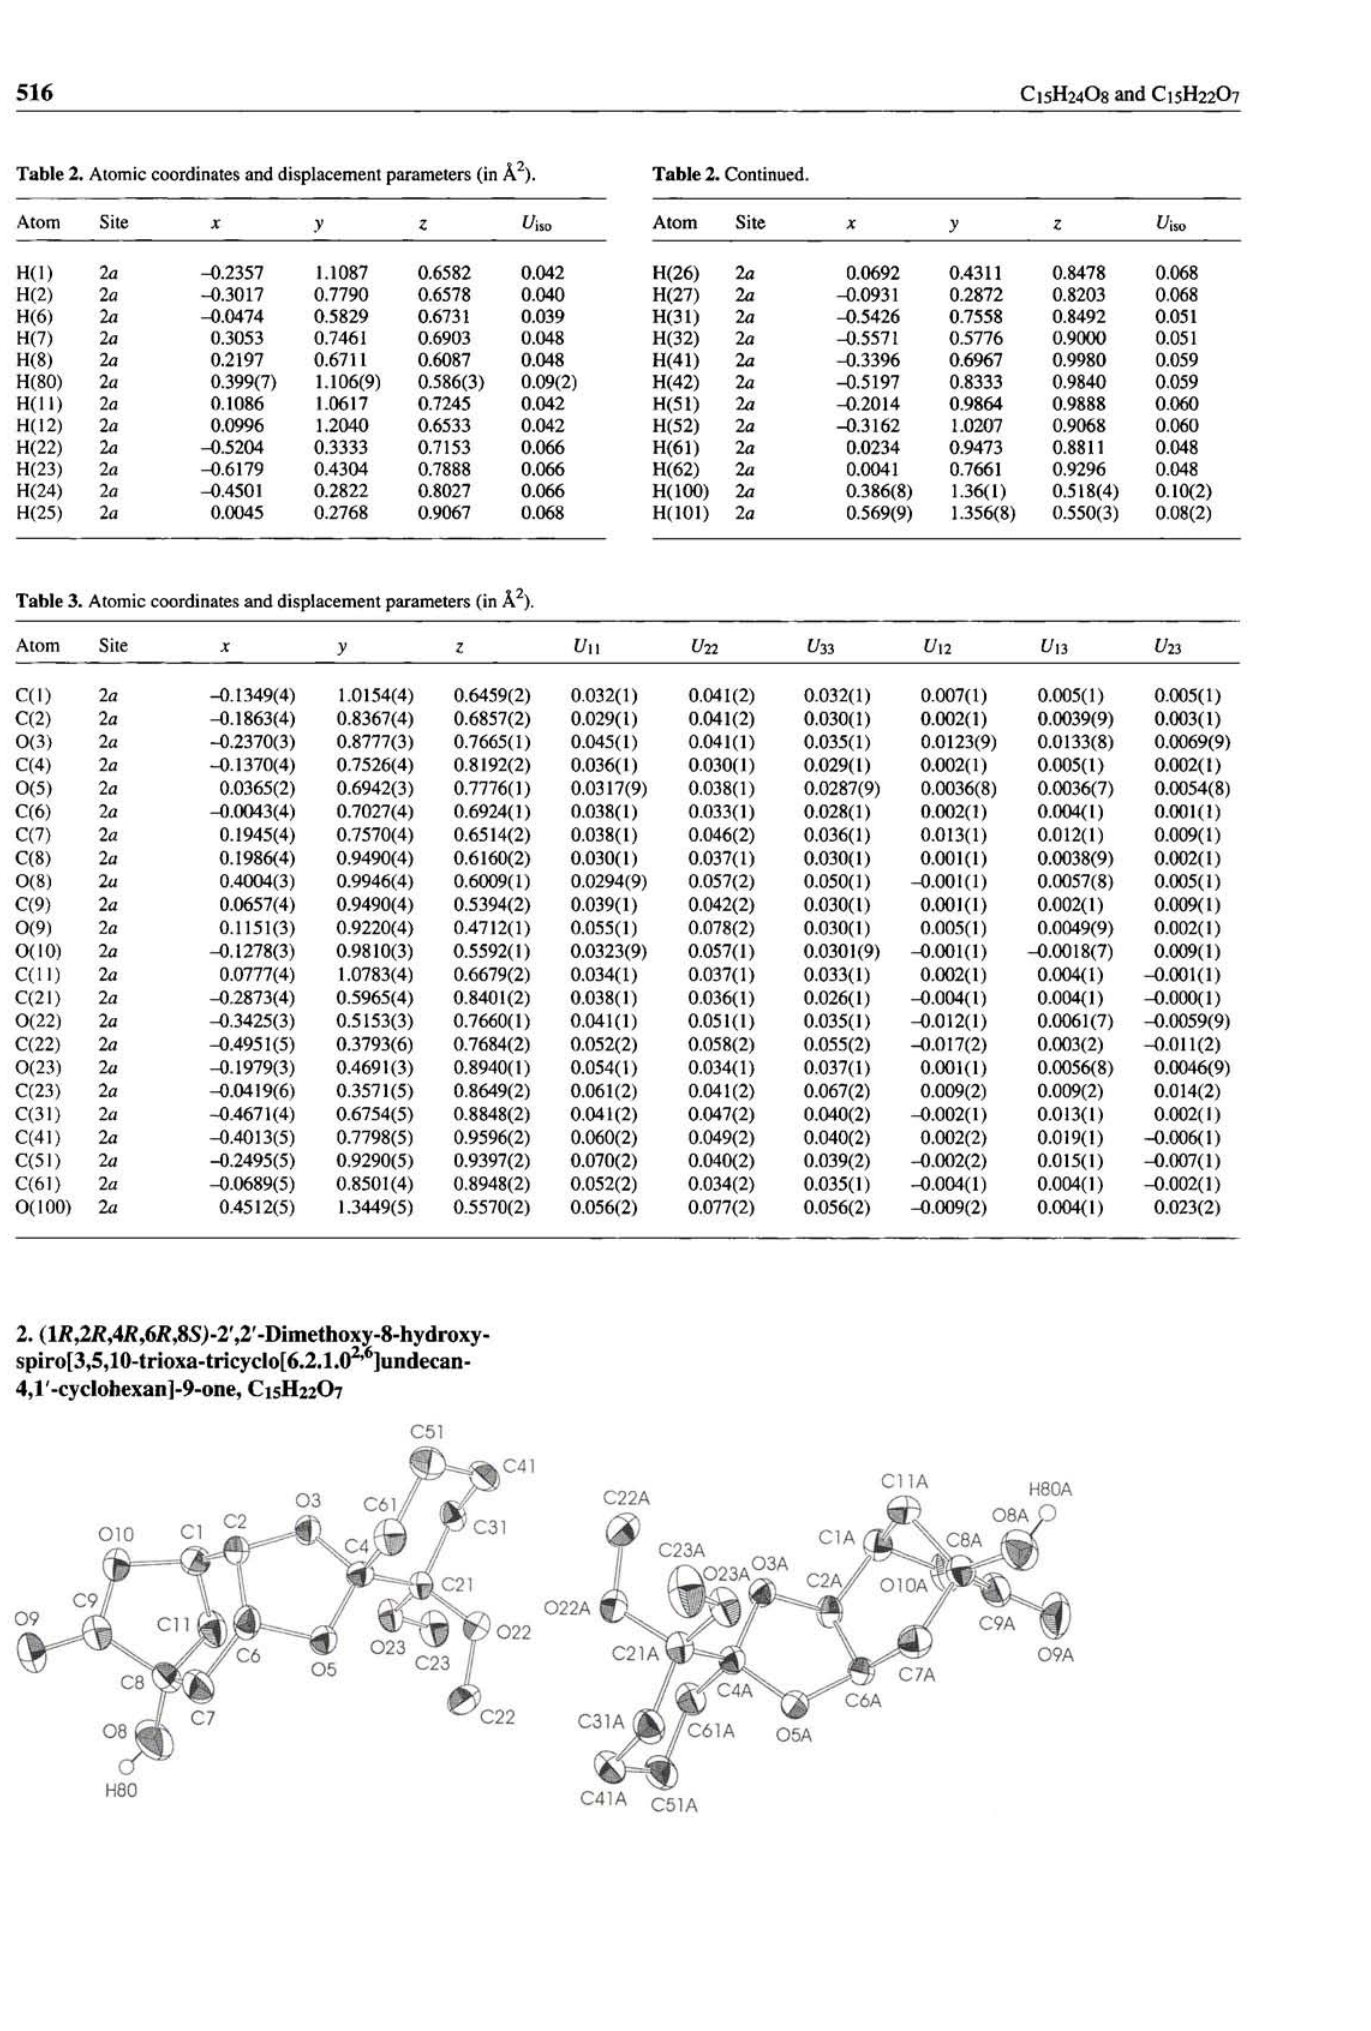
Table 2. Atomic coordinates and displacement parameters (in A 2 ).